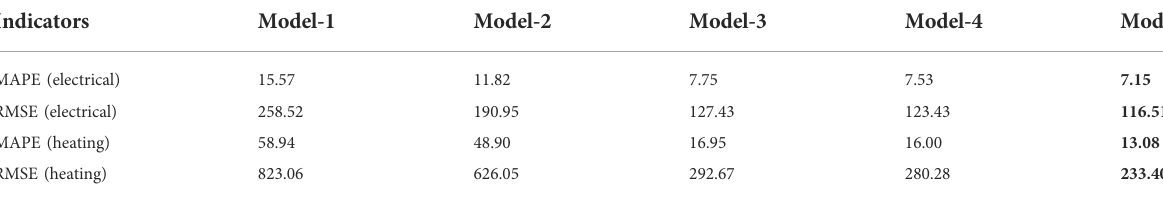
TABLE 2 Indicator results of the different models for the heating period in Case 2.